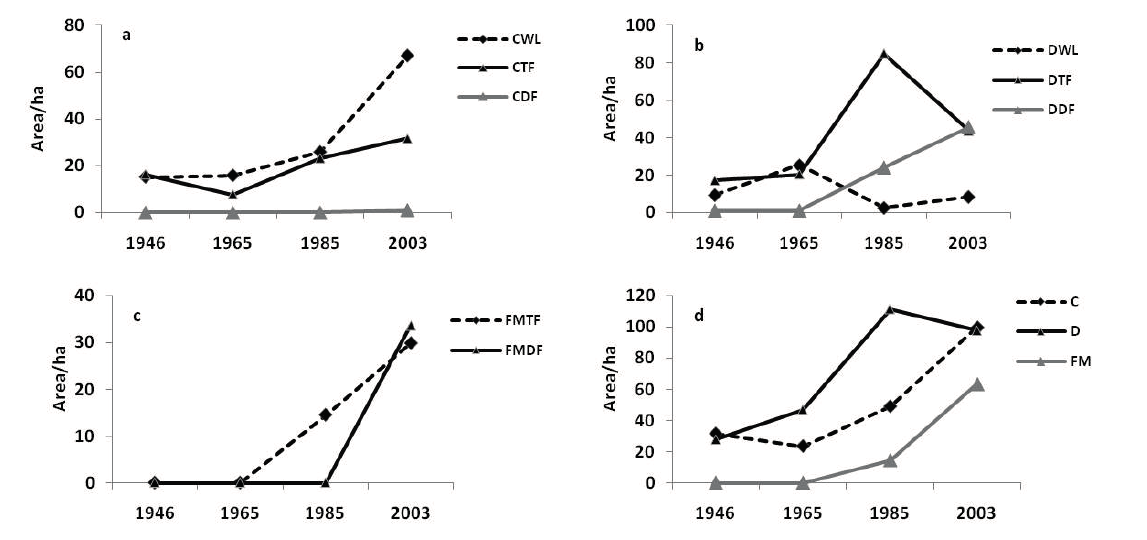
Figure 5. ( a ) Changes in area (ha) of conifers between 1946 and 2003: Conifer woodland (CWL), Conifer thin forest (CTF), Conifer dense forest (CDF). ( b ) Changes in area (ha) of deciduous between 1946 and 2003: Deciduous woodland (DWL), Deciduous thin forest (DTF), Deciduous dense forest (DDF). ( c ) Changes in area (ha) of mixed forest between 1946 and 2003: Mixed forest thin forest (FMTF), Mixed forest dense forest (FMDF). ( d ) Changes in area (ha) of different forest types: Deciduous (D), Conifer (C), Mixed forest (FM) between 1946 and